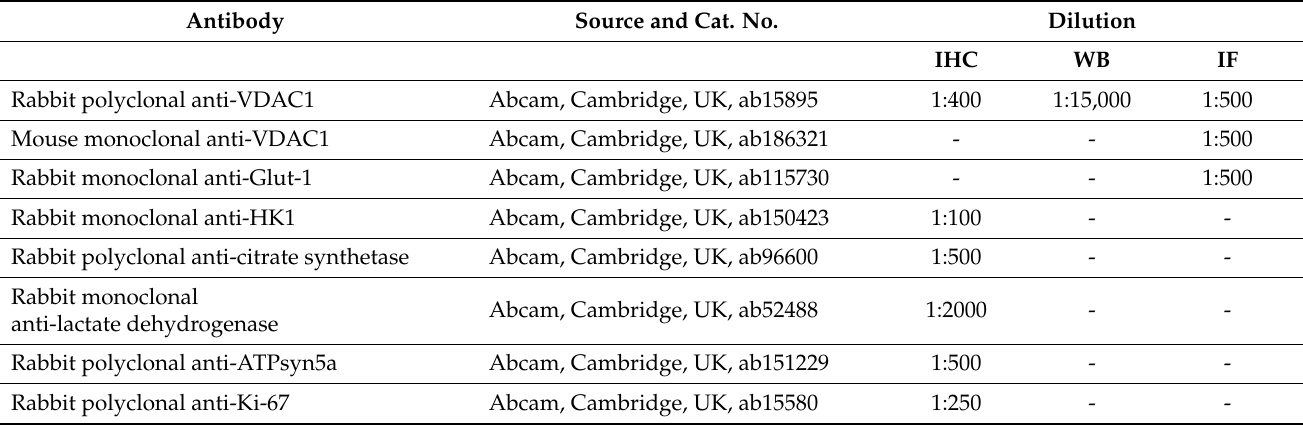
Table 1. Antibodies used in this study. Antibodies against the indicated protein, their catalogue number, source, and dilutions used in immunoblotting (WB), immunofluorescence (IF), and immuno- histochemistry (IHC) experiments are presented below: Antibody Source and Cat.